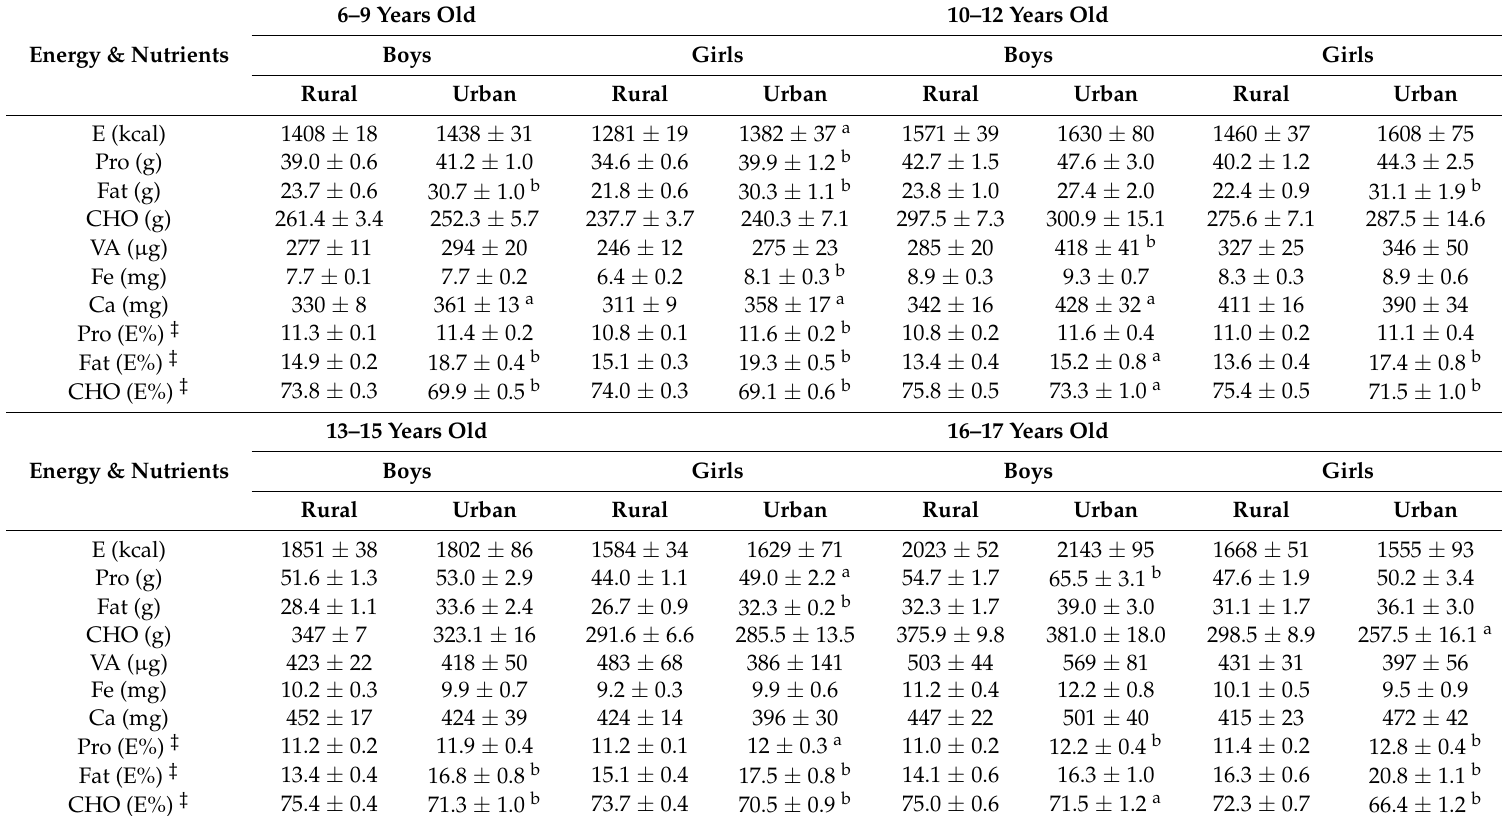
Table 3. Intake of energy and selected nutrients and the percentage (%) from total energy by age group and area of residence (mean values ± standard errors) † .